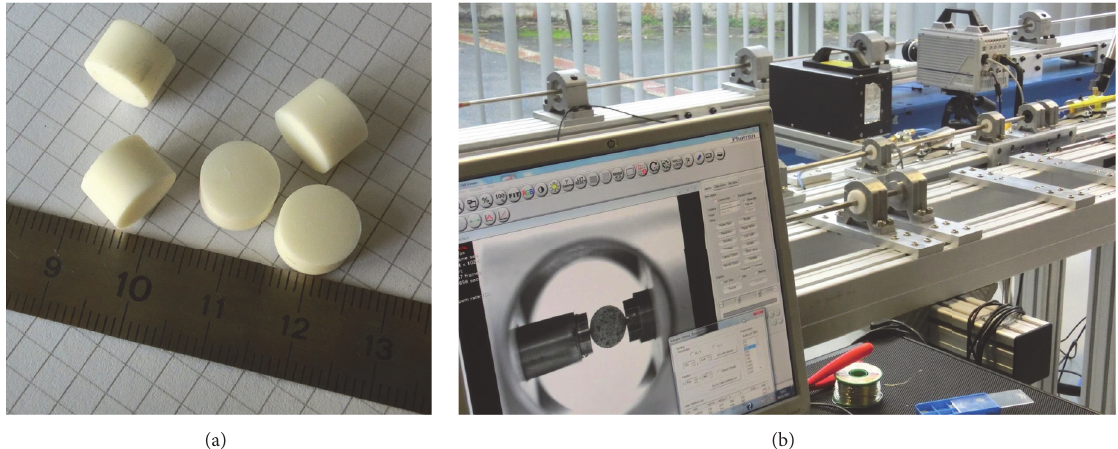
Figure 2: Specimens used for Brazilian test (a); detail of the Split Hopkinson Pressure Bar for high loading rate tests (b).